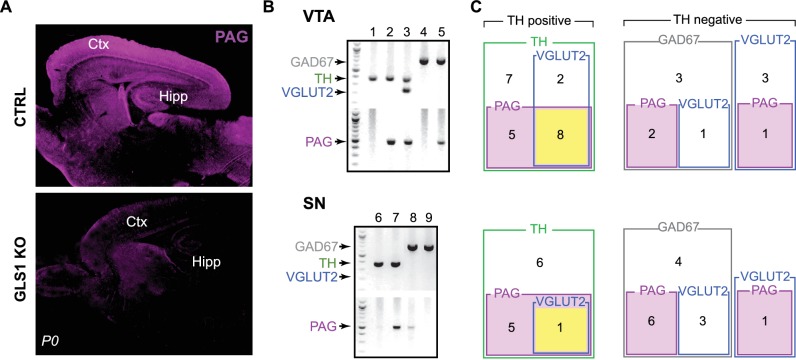
Expression of PAG in dopamine neurons.(A) Validation of the phosphate-activated glutaminase (PAG) antibody in GLS1 KO mice (neonates were used since KOs survive only for a few hours). Immunoreactivity was absent in GLS1 KO brain. Sagittal sections are shown. Abbreviations: Ctx, cortex; Hipp, hippocampus. (B) Sample gel images of single-cell reverse transcription (RT) PCR from the VTA (top) and the SN (bottom). For each region, the upper gel shows the multiplex result for glutamate decarboxylase (GAD67, 702 bp), tyrosine hydroxylase (TH, 377 bp), vesicular glutamate transporter (VGLUT2, 250 bp); the lower gel shows PAG (512 bp). Numbers on the top of each image are cell numbers; each lane in the multiplex gel (top) and PAG gel (bottom) was from the same cell. (C) Euler diagrams showing RT-PCR results in the VTA (top) and the SN (bottom). Numbers inside each square indicate the number of cells expressing the gene or combination of genes. TH+ cells are grouped (green square) in the diagram on the left; TH— cells are divided into those expressing GAD67 (gray squares) and VGLUT2 (blue squares), on the right. PAG expressing cells are indicated by magenta-filled magenta squares. Cells expressing TH, VGLUT2 and PAG are indicated by yellow filled squares. There was no overlap of TH and GAD.